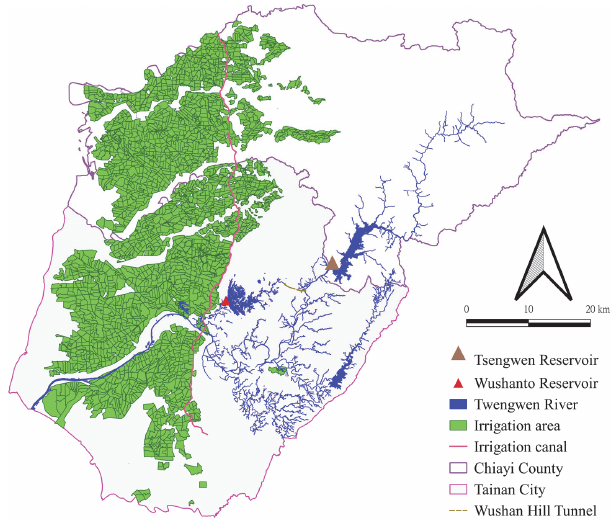
Figure 1. The map of Tsengwen and Wushanto